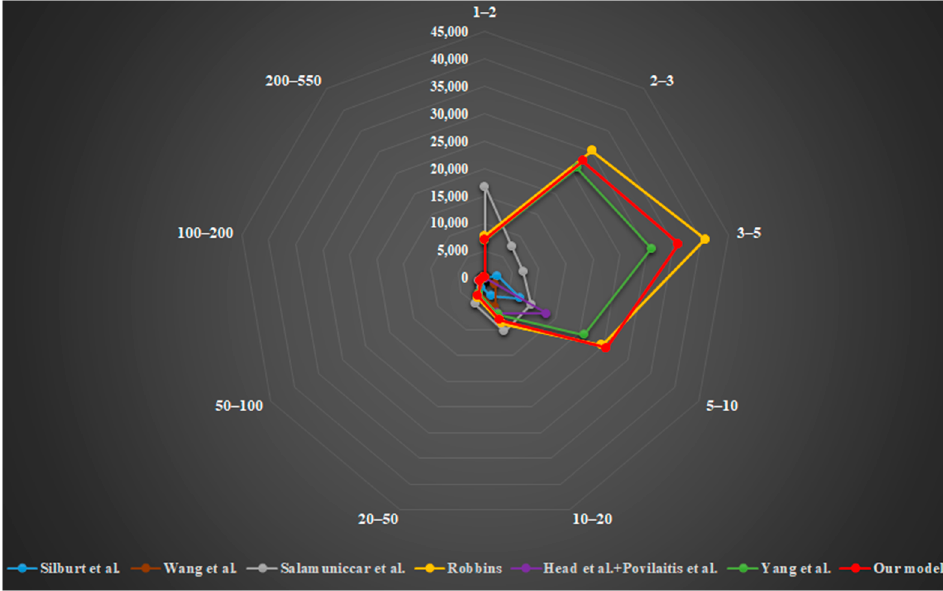
Figure 10. Comparison results of the number of the matched craters at different scales .